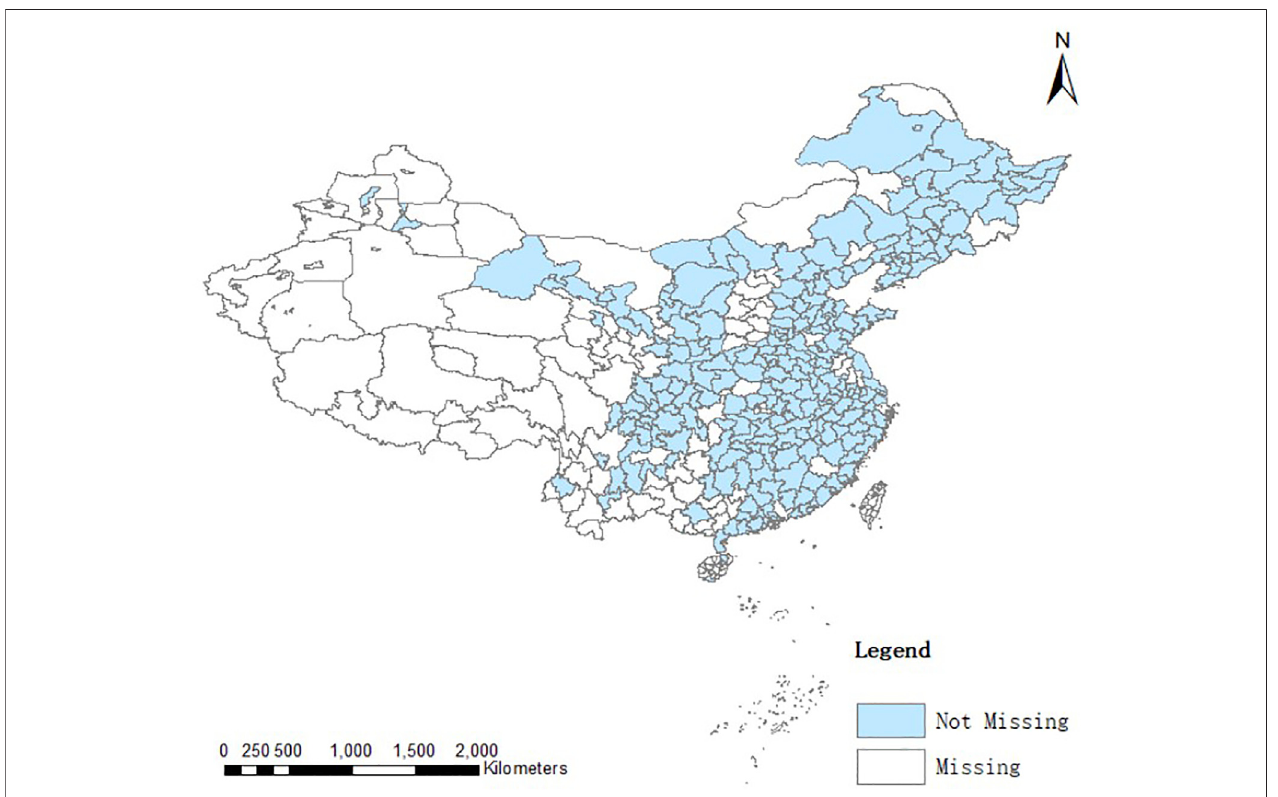
FIGURE 4 | Prefecture-level hog inventory data (249